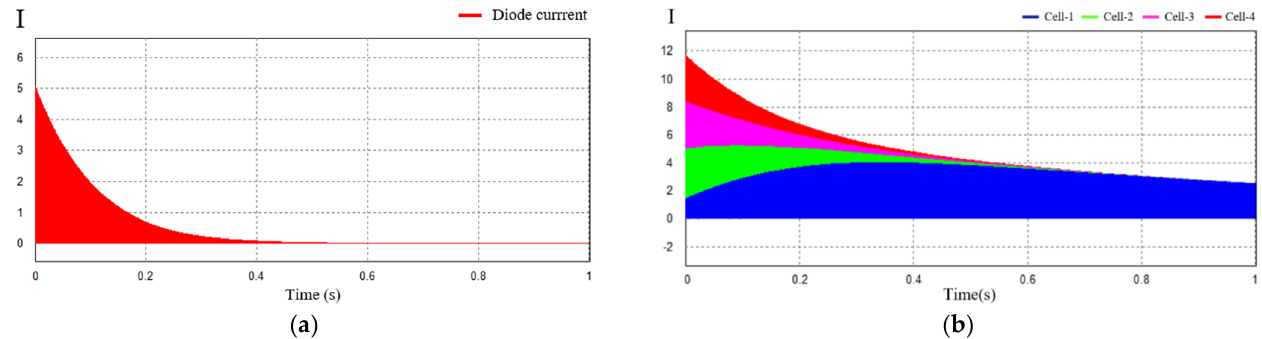
Figure 11. Circuit for simulation and verification ( a ) 1st diode current of converter; ( b ) battery cell current.